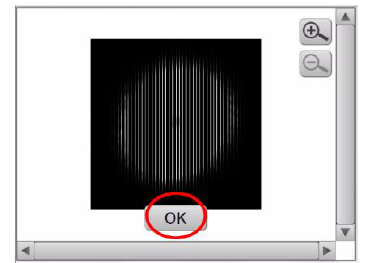
Figure 24. The display of scanning result for target scan